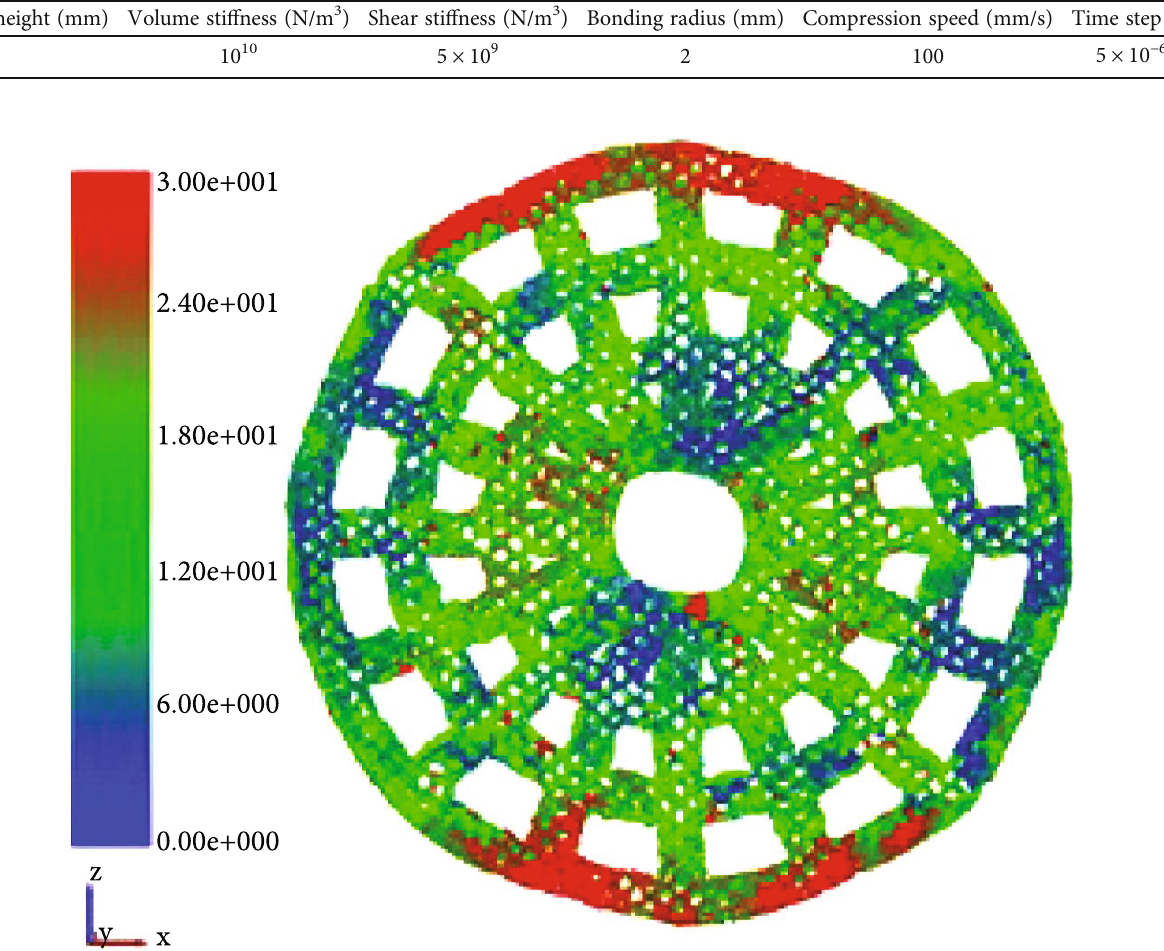
Table 2: Discrete element parameters of cobweb